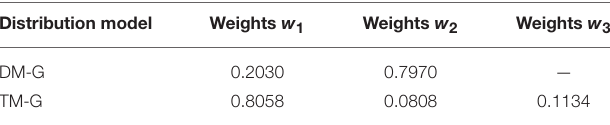
TABLE 6 | Weight value of mixed probability density distribution of Xichang data on August 9, 2018.